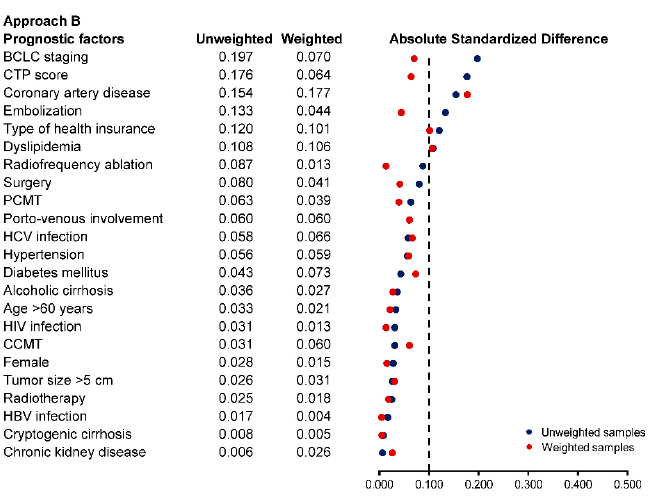
Figure 2. Balance in prognostic factors at 12 months after diagnosis for approach B (emulated 320 cohort) based on absolute standardized difference in the unweighted and weighted clone samples. 321